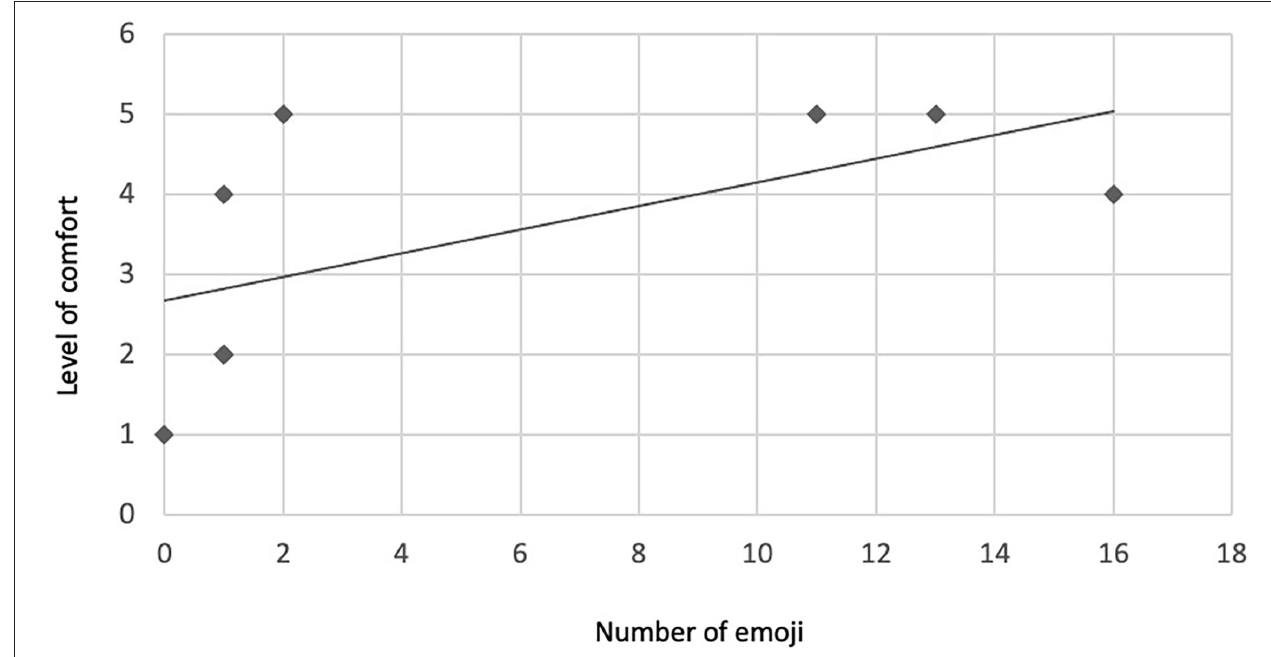
FIGURE 2 | Level of comfort in relation to emoji use (emoji